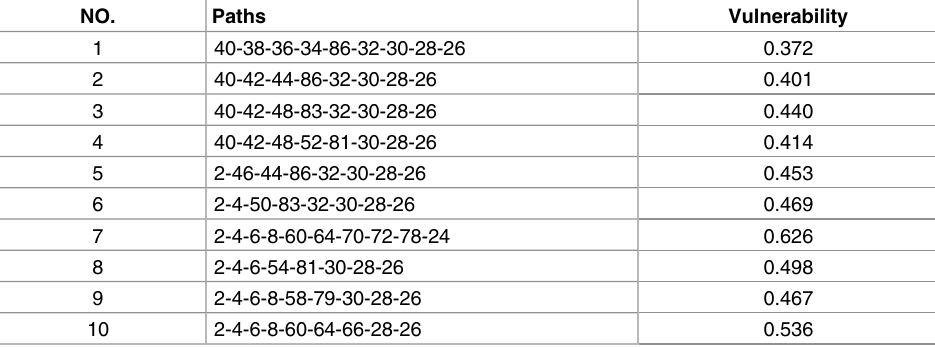
Table 1. Vulnerability of partial routes of OD